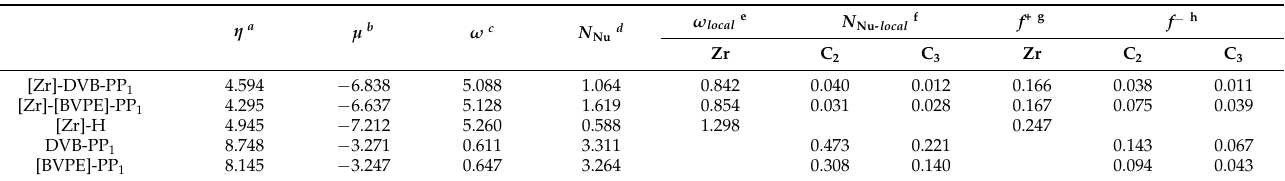
Table 3. The global reactivity index, local reactivity index, and Fukui function values for some molecules.